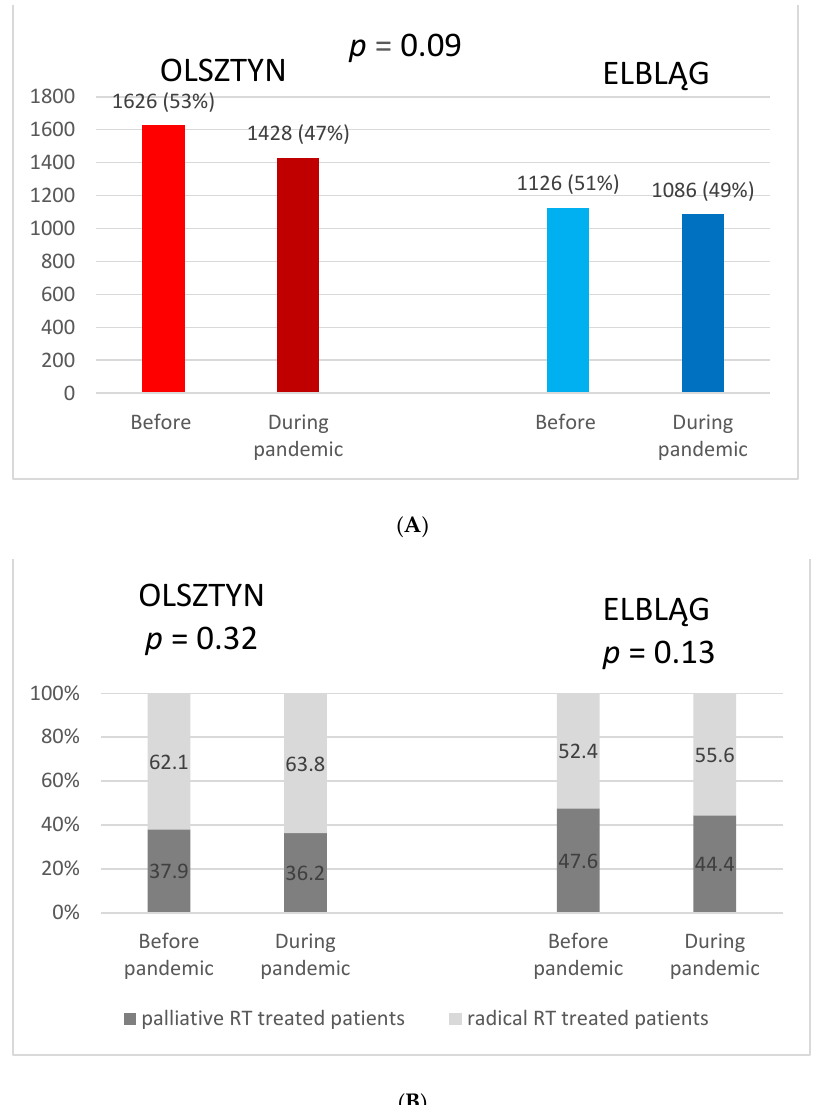
Figure 1. Comparison of radiotherapy procedures before and during the pandemic between Olsztyn and Elbląg ( A ). Comparison of percentage of RT procedures due to radical and palliative intention in Olsztyn and Elbląg ( B ).